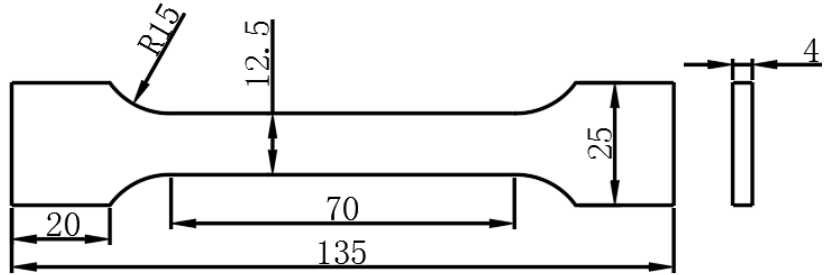
Figure 2. Sample for mechanical property testing (mm).